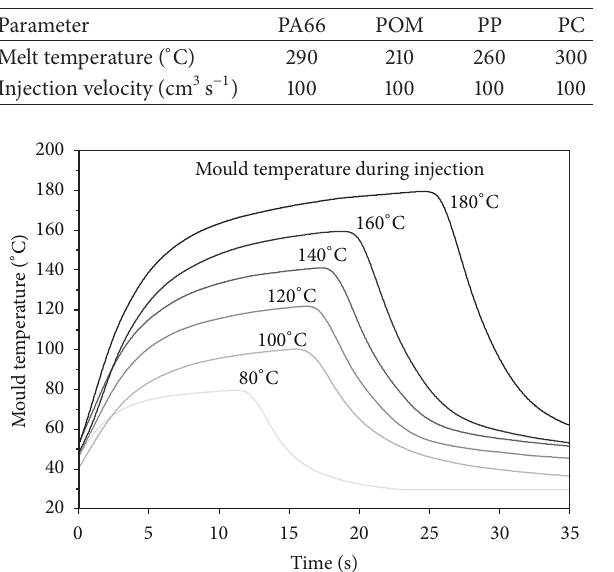
Figure 2: Mould temperature of the variothermal injection mould- ing process with different mould temperature for injection mould- ing.